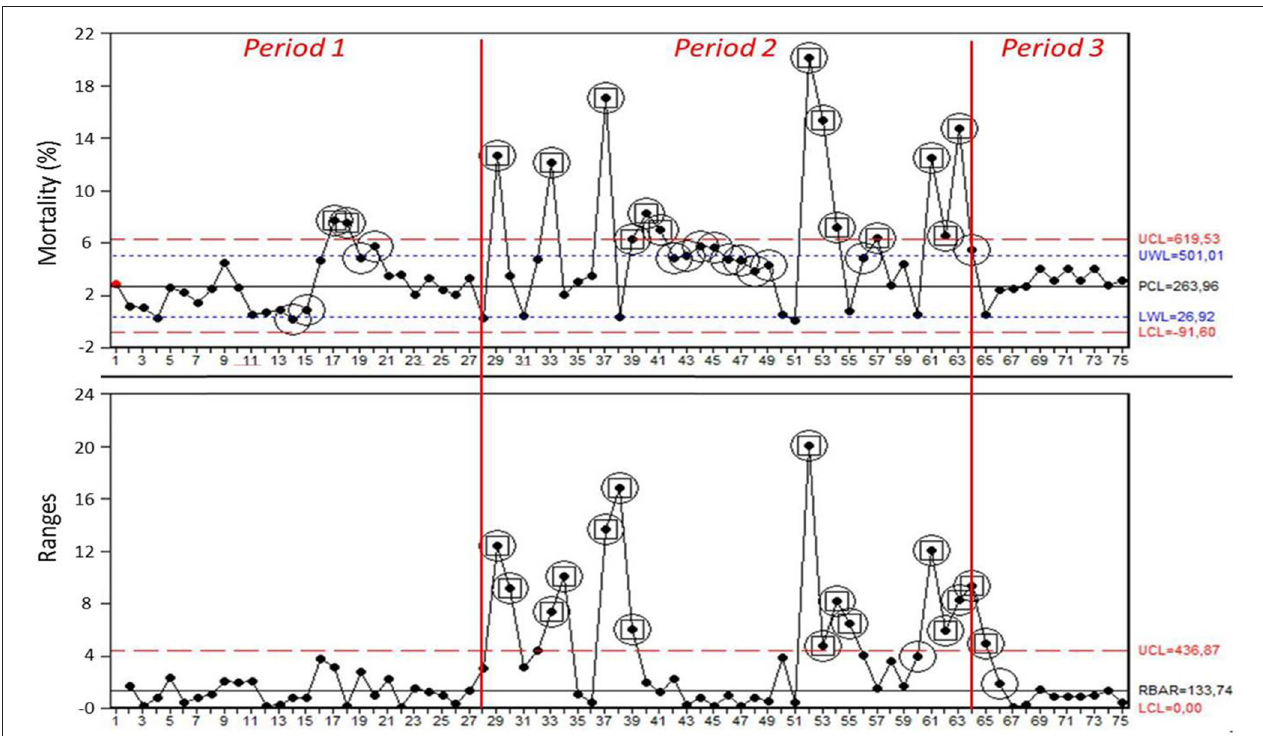
FIGURE 1 | I-MR charts for mortality (%) in each batch obtained from the analysis of the 3 Periods (Period 1 = 1–28; Period 2 = 29–63; Period 3 = 64–75). Process center line (PCL, black line), upper control limit and lower control limit (UCL, LCL, red dotted lines), and upper warning limit and lower warning limit (UWL, LWL, blue dotted lines) were calculated based on observations of Period 1. Circled points showed at least one signal of special cause variation, as expressed by software tests. Circled and framed points showed to be out of control in the